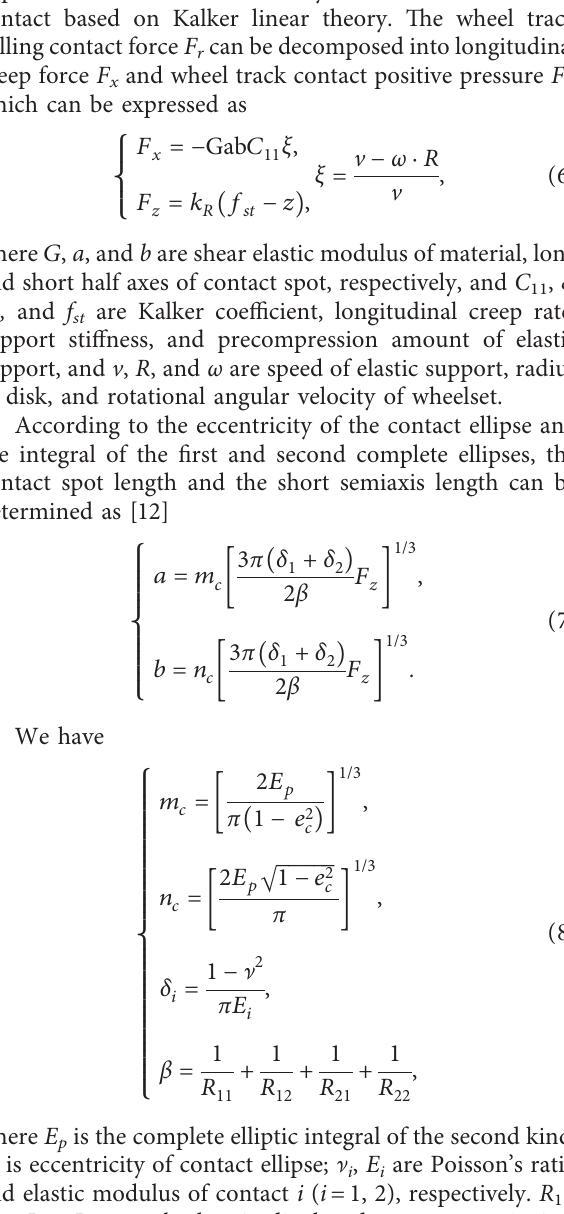
Table 2: Calculation parameters of wheelset rotor